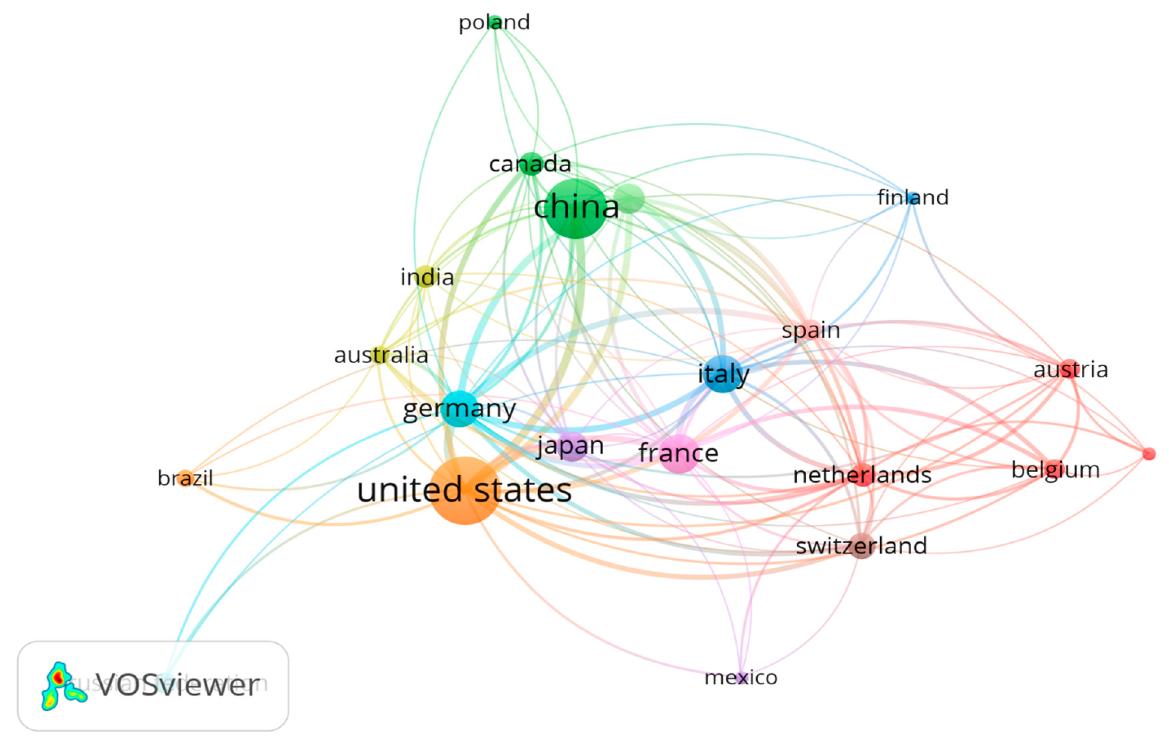
Figure 3. Top 20 Collaboration between Countries Network on EOS and PM Studies.